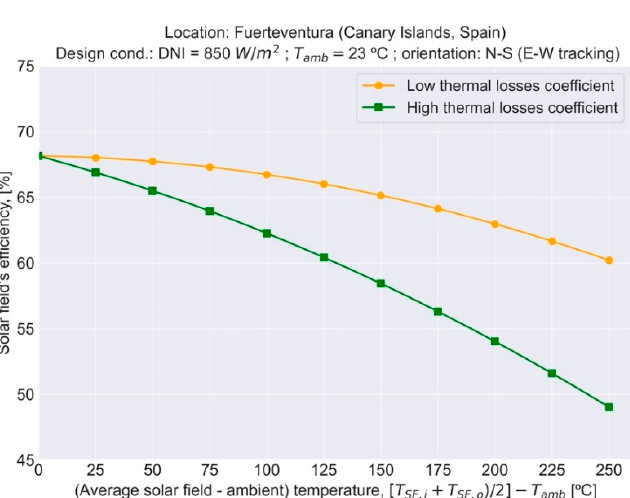
Figure 9. Solar field’s efficiency according to the parameters fixed in Table 3.